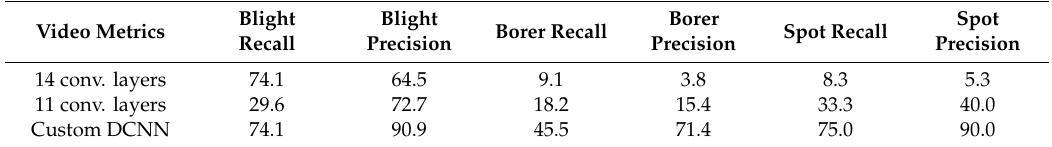
Table 6. Video metrics of di ff erent depth of the custom DCNN backbone using Video 1 (%). Video 1 is illuminated in Section 2.1.